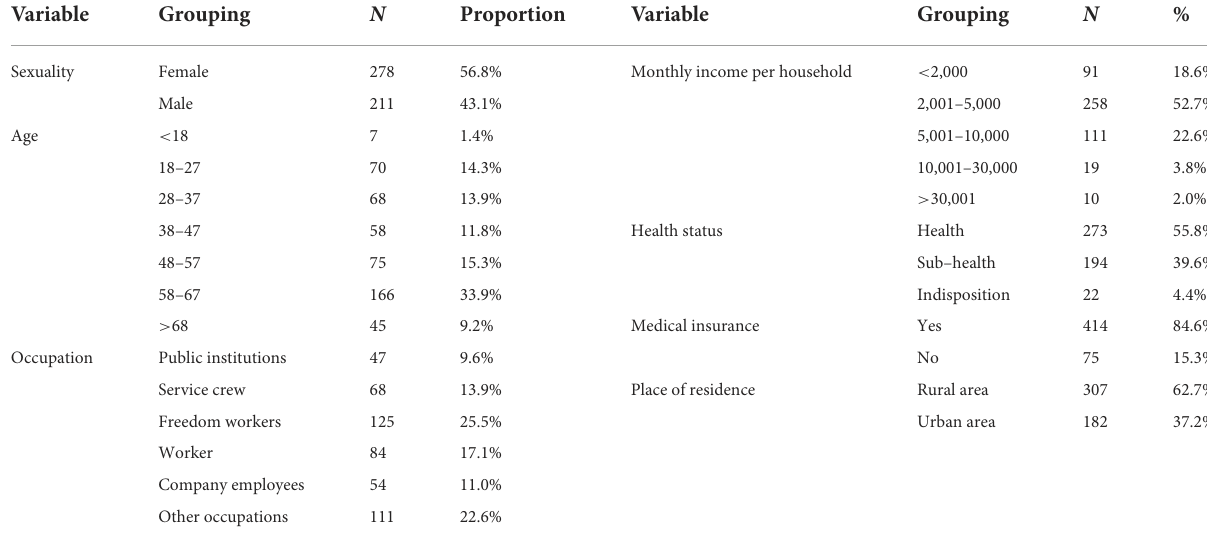
TABLE 4 Statistical table of basic information of